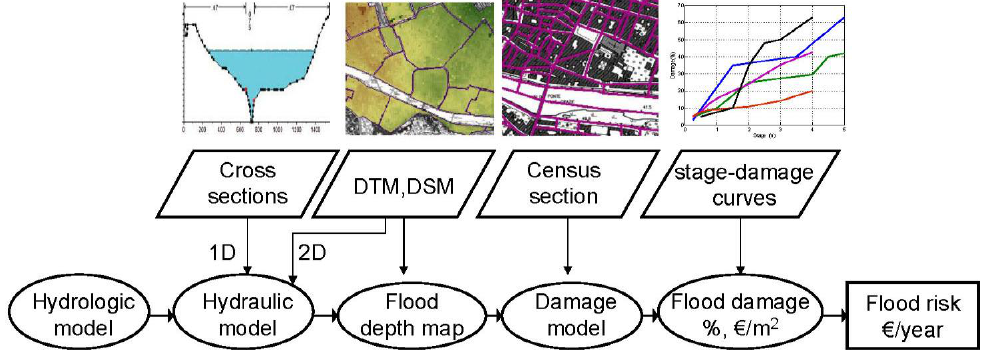
Fig. 1. Main flow chart for urban micro-scale flood risk assessment. Figure 1. Main flow chart for urban micro-scale flood risk assessment. 2 (streets/buildings scale) representation of the flow